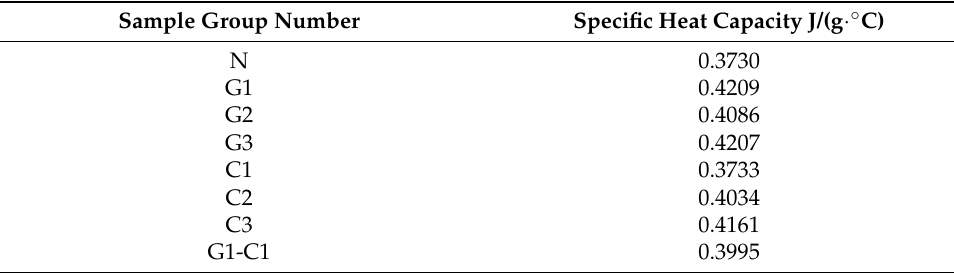
Table 7. Specific heat capacity of WC–Co cemented